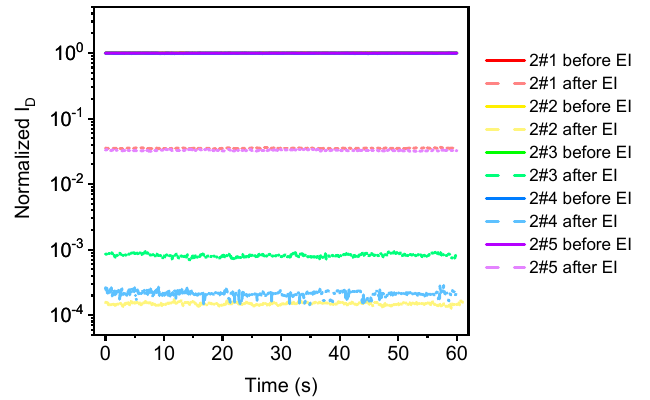
Figure 12. I–t curve of graphene samples before and after electron irradiation.